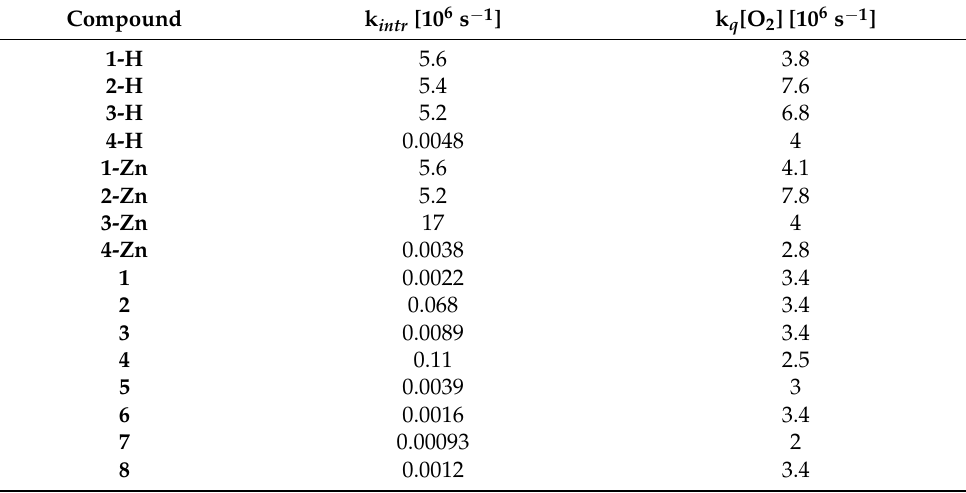
Table 2. Rate constants of intramolecular and oxygen-induced triplet